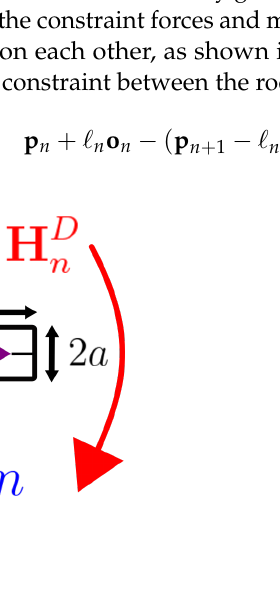
Figure 3. Representation of a pointwise rod element of length 2 l and cross-sectional diameter 2 a . The force D n and the torques T D n and H D n exerted by the surrounding flow on the element are also shown, together with the position unit vector p n and the orientation unit vector o n .